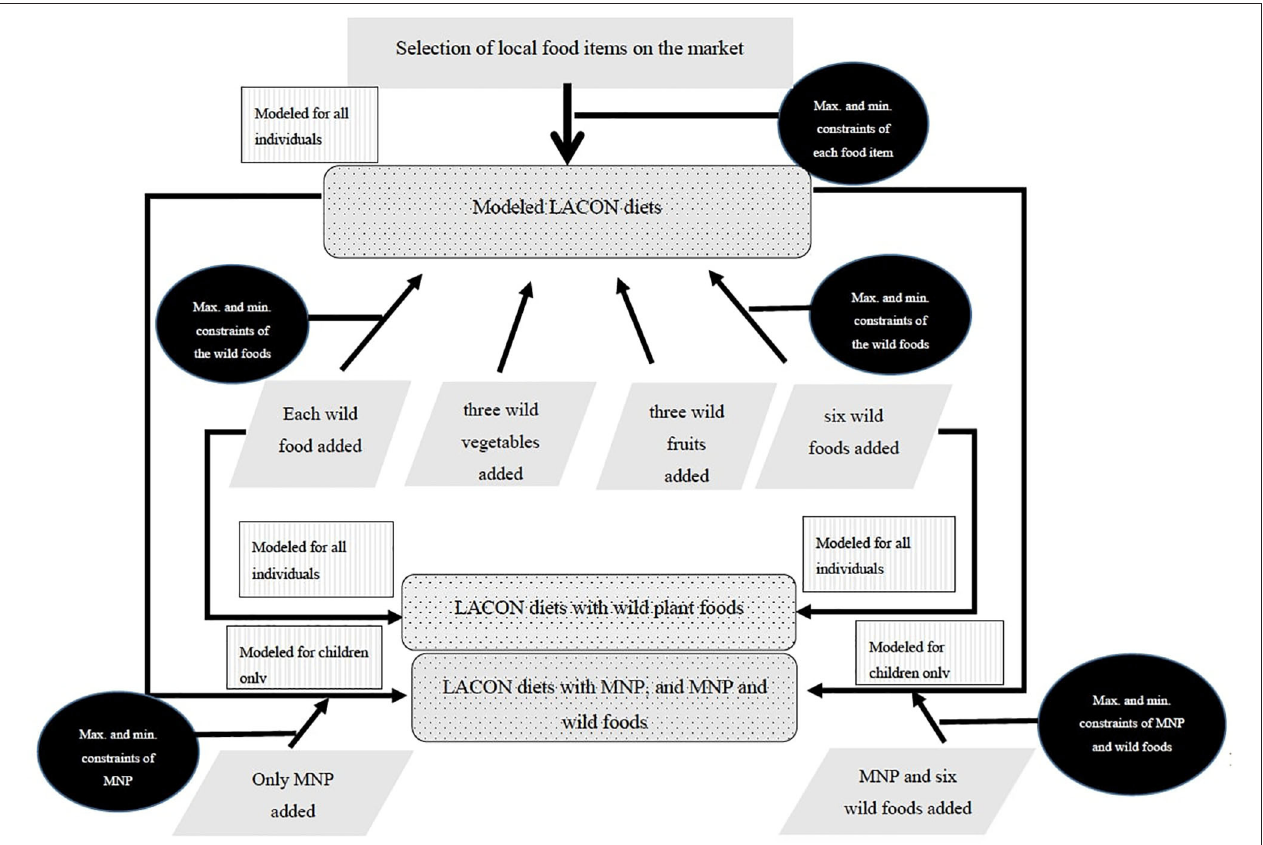
FIGURE 1 | Flow chart depicting how locally adapted cost optimized nutritious (LACON) diets were modeled for women and children in Turkana with and without the inclusion of wild foods and/or micronutrient powder (MNP).